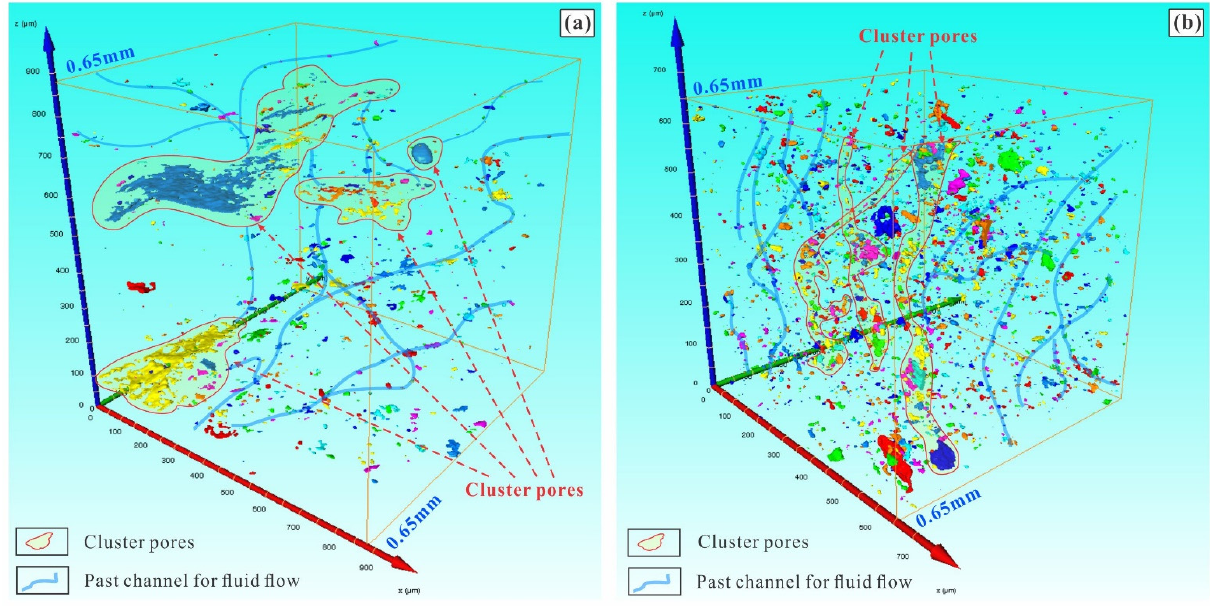
Figure 10. The arrangement characteristics of the pores in the Micro-CT images. ( a ) The pores dis- tribution in marine shale sample HD1-17. ( b ) The pore distribution in lacustrine shale sample LMS-